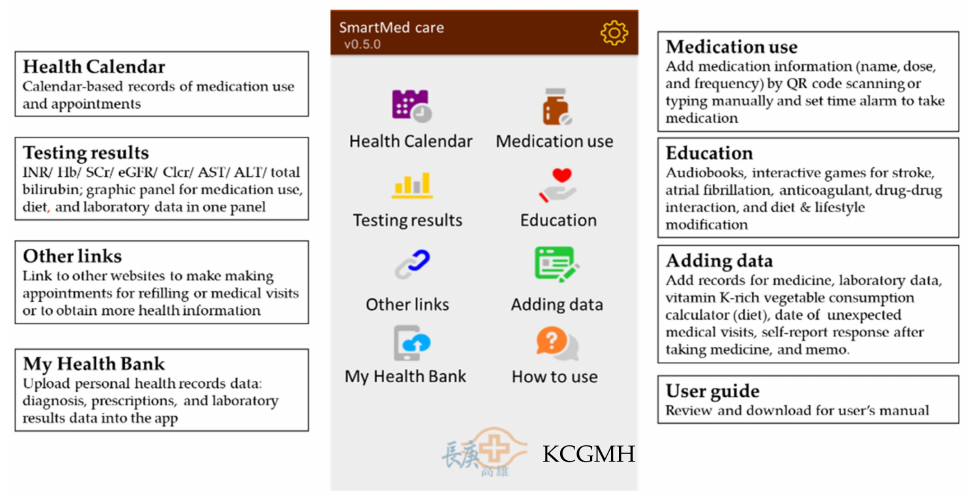
Figure 2. Main features of SmartMed app (KCGMH, Kaohsiung Chang Gung Memorial